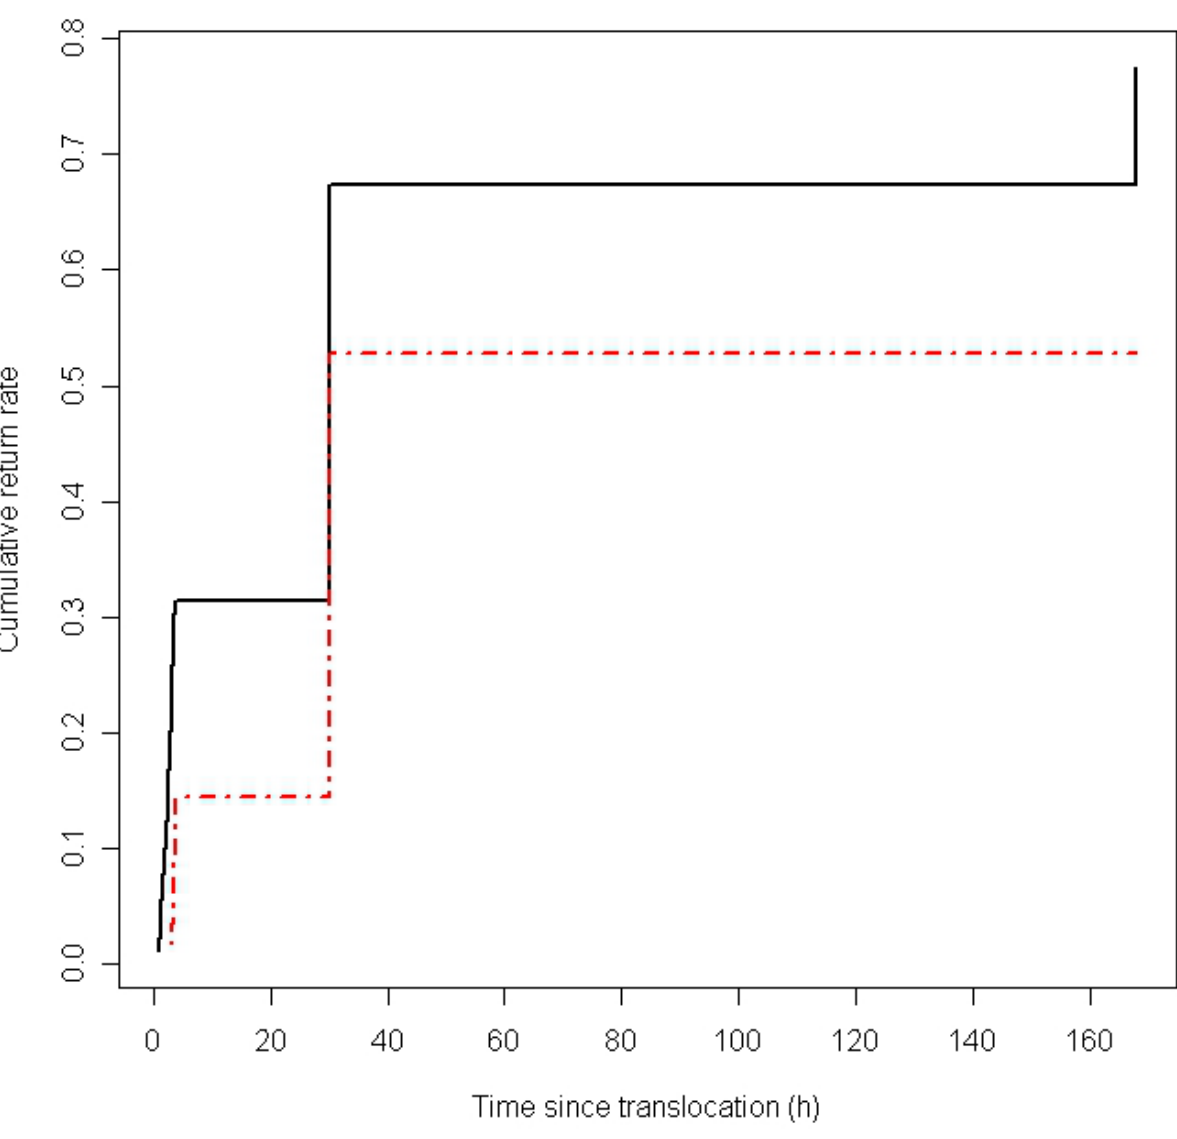
Fig. 1. Cumulative return of translocated Ovenbird in the boreal mixedwood forest of north-central Alberta (red; n = 55) and the temperate, northern hardwood forest of southern Québec (black; n = 89). Values are based on Kaplan–Meier